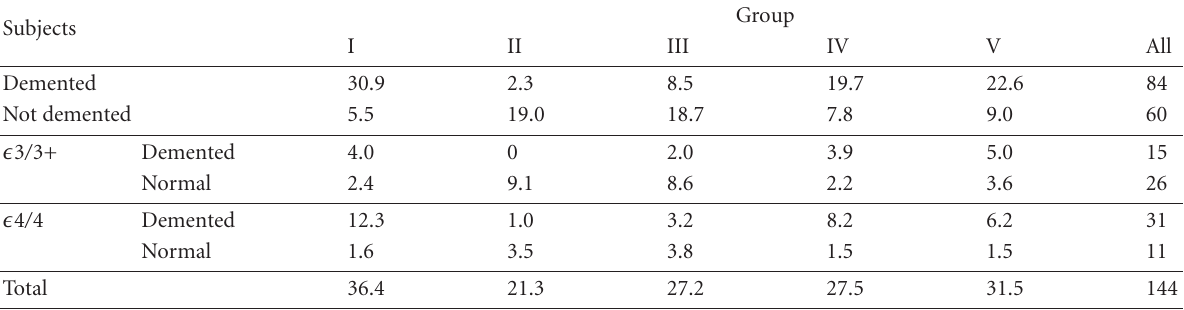
Table 7. Distribution of subjects across the groups, subdivided according to dementia status and APOE genotype; (cid:1) 2 / 2 and (cid:1) / 2 / 3 were grouped with (cid:1) 3 / 3; (cid:1) 2 / 4 and (cid:1) 4 / 4 were grouped with (cid:1) 3 / 4. The sizes are the sums of the model g ik parameters, that is, the memberships of individuals in the groups, whole or